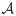
(Color online) a) Simulated normalized harmonics (data points) over a range of the master variable A are fit by a domain-scaled Langevin function (lines). b) Inset are the values of the computational fitting parameters for each harmonic bl and the associated R2 > 0.98 values indicating the strong fit.